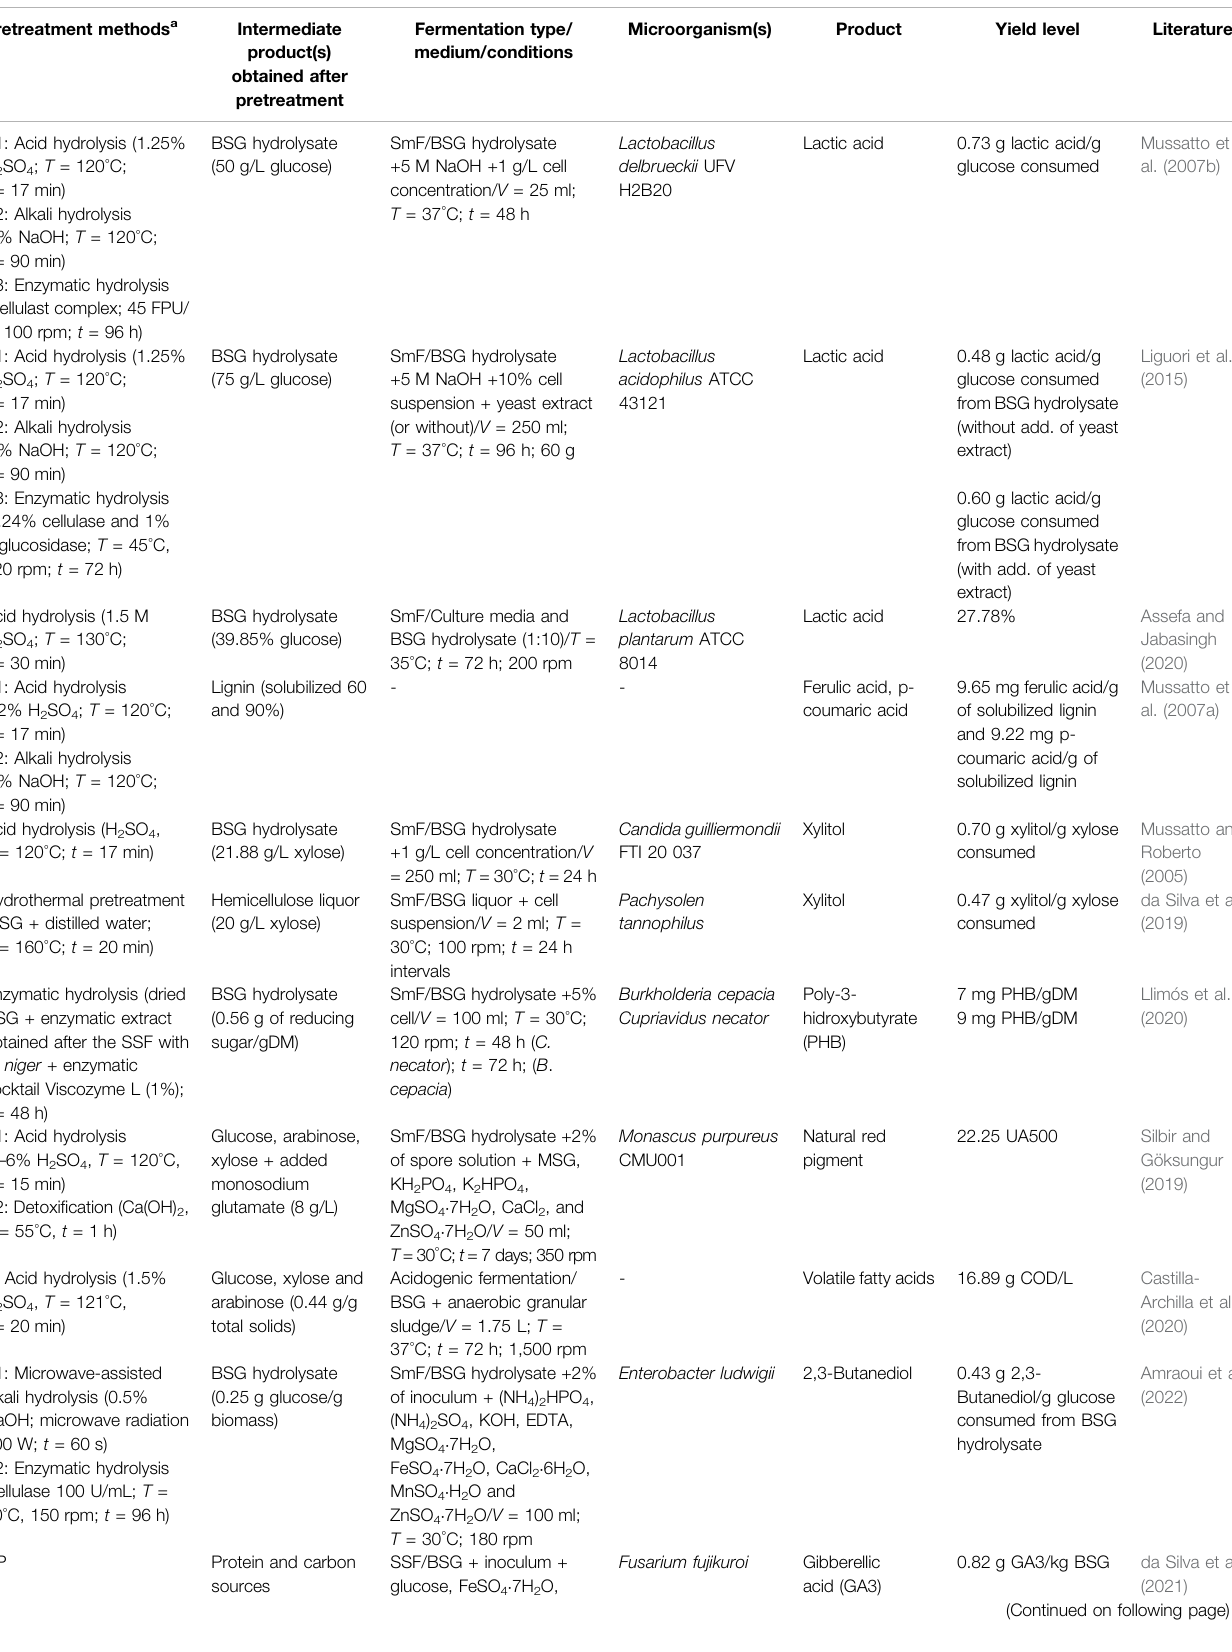
TABLE 4 | Production of value-added products from BSG